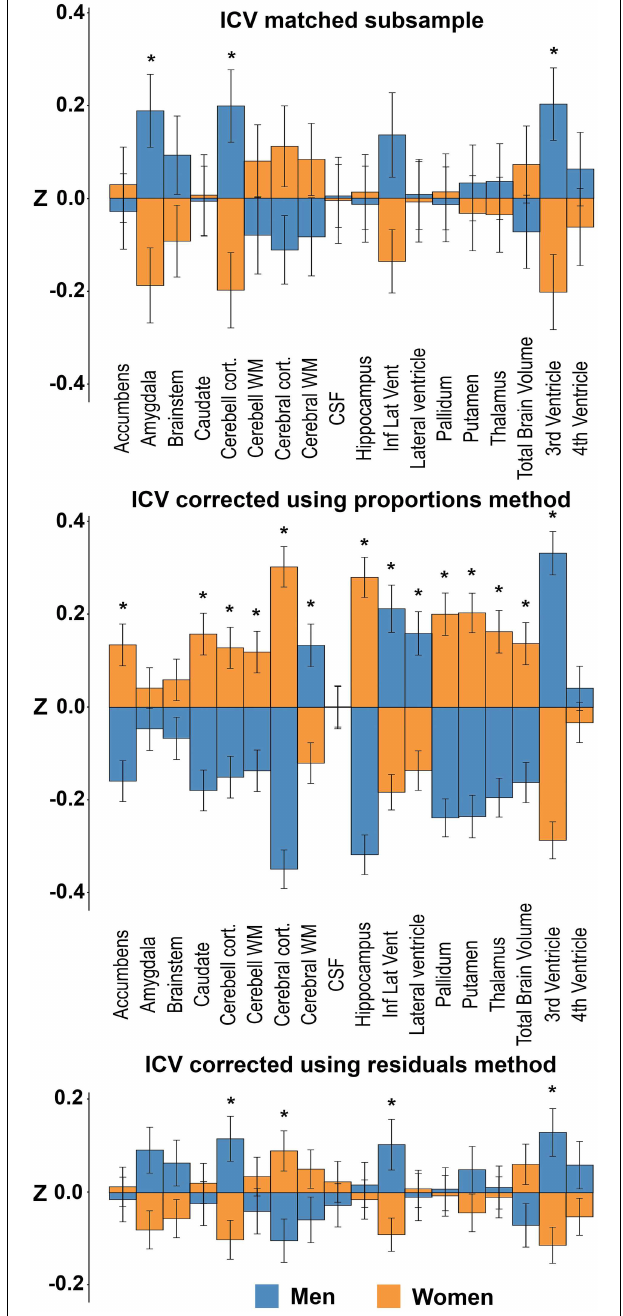
FIGURE 6 | Sex differences in the ICV-matched subsample and using the different ICV-correction methods. The bars illustrate mean standardized volume for men (blue) and women (orange) with the standard error superimposed. Y-axis: Z-score of the residuals. Top : ICV-matched subsample. Middle : ICV-corrected using the proportions method. Bottom : ICV-corrected using the residuals method. * Corrected p < 0 . 05 .